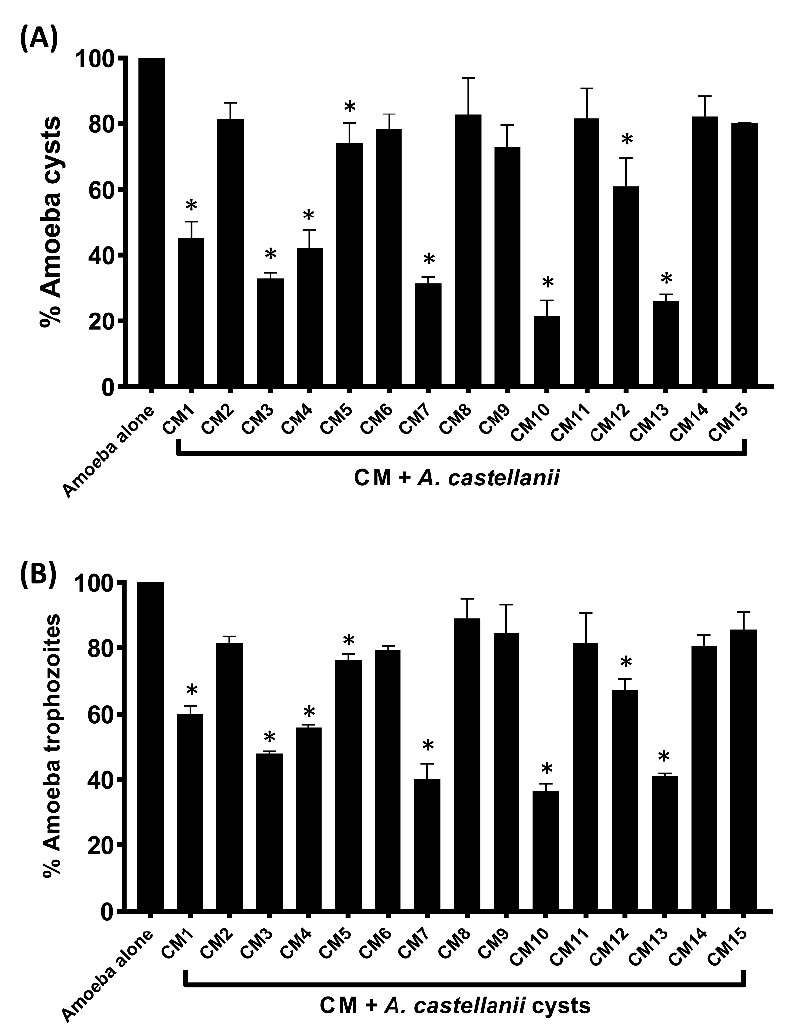
Figure 3. ( A ) Effects of CM on the encystation of A. castellanii trophozoites. The results showed that CM inhibited the encystment of trophozoite form compared to the negative control. The data are presented as the mean ± standard error. p values were calculated using a two-sample t -test with a two-tailed distribution, and (*) denotes that p ≤ 0.05. ( B ) Effects of CM on A. castellanii excystation. When compared to the negative control, the results demonstrated that CM reduced the excystment of trophozoites. Overall, the CM prevented the excystation process in amoebae. The data are presented as the mean ± standard error. p values were calculated using a two-sample t -test with a two-tailed distribution, and (*) denotes that p ≤ 0.05.